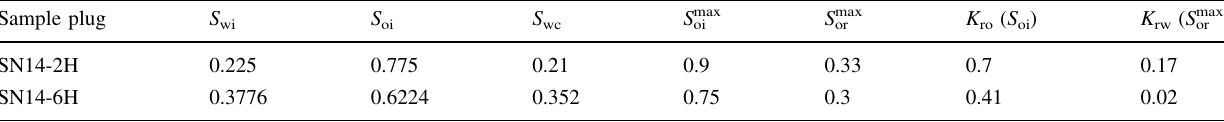
Table 10 End point parameters of permeability and saturation for the core samples Sample plug